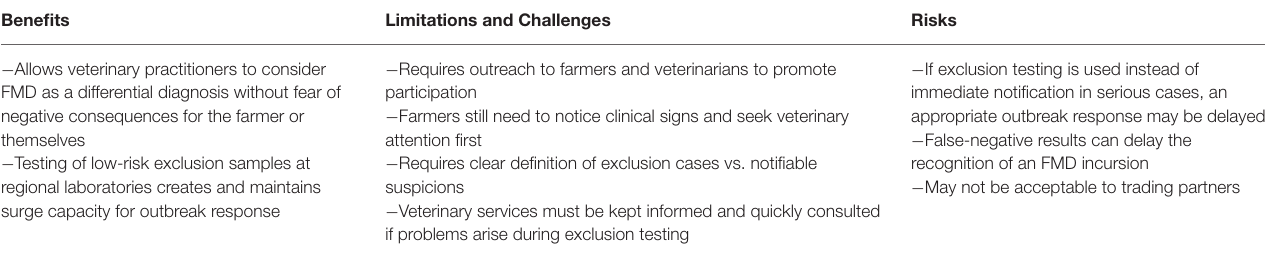
TABLE 1 | Benefits, limitations, and risks associated with non-discriminatory exclusion testing schemes for FMD. Benefits Limitations and Challenges